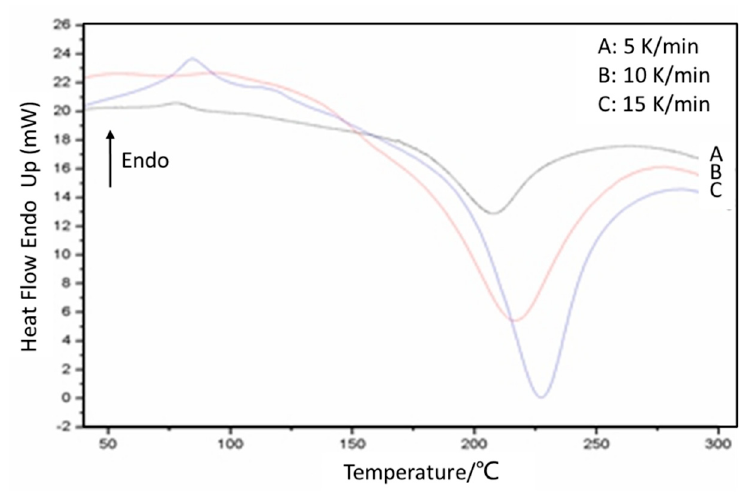
Figure 3. The viscosity-temperature relation of SAA and ZAA. 3.3. DSC Analysis Figure 4 shows the DSC curing exothermic curve of ZAA at the heating rate of 5 °C/min, 10 °C/min and 15 °C/min, respectively. It could be seen that the exothermic rate increased with the heating rate increasing, and the peak temperature also drifted towards a higher temperature due to the thermal hysteresis effect. There is a small endothermic peak around 50–70 °C in the curves of heating rates of 5 and 15 °C/min, which was caused by the volatilization of some small molecule